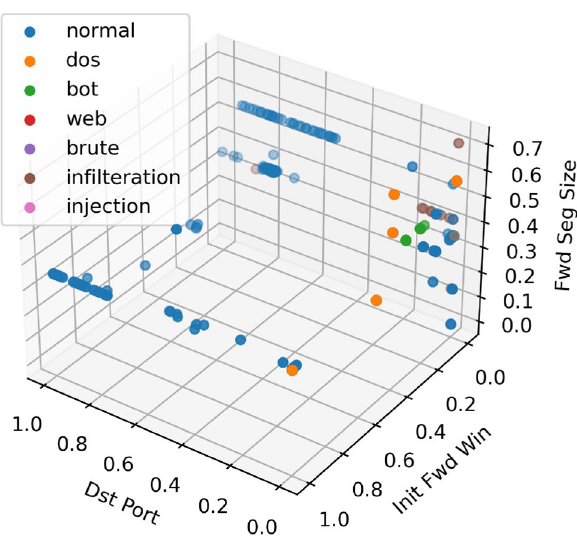
Figure 7. Visualization of dataset with top 3 features. Dst Port, Init Fwd Win and Fwd Seg Size